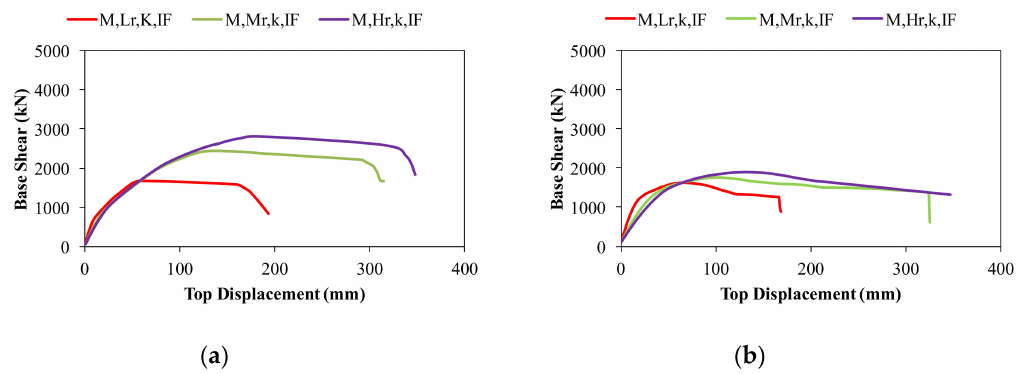
Figure 6. Pushover curves of the selected M-archetype buildings in ( a ) X-direction and ( b ) Y-direction.